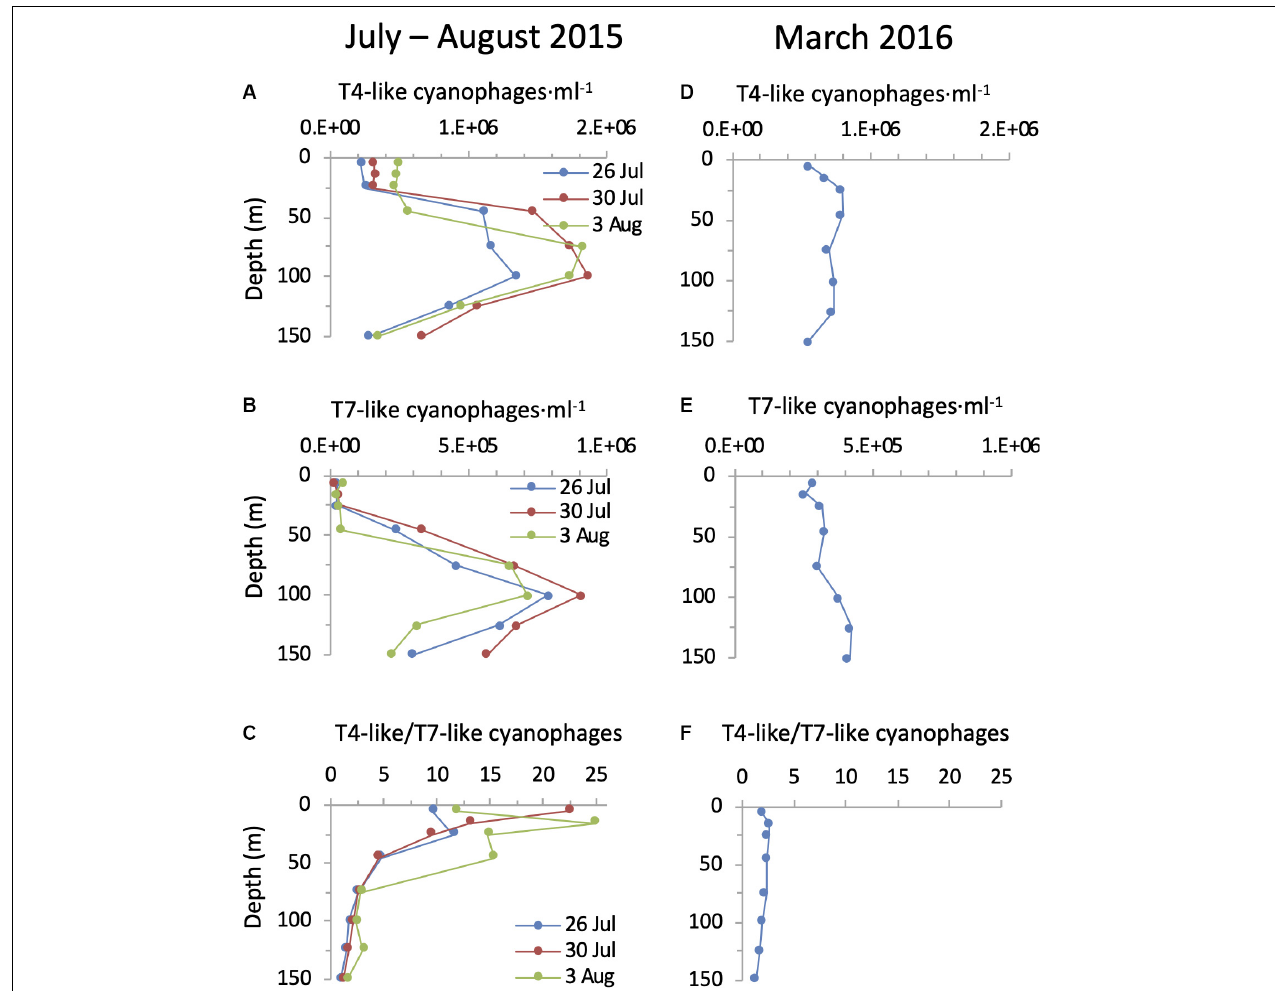
FIGURE 6 | Depth distribution of cyanophages in the NPSG. Abundances of T4-like cyanophages (A,D) , T7-like cyanophages (B,E) and the ratio of T4-like to T7-like cyanophages (C,F) during the summer cruise in July–August 2015 (left panels) and in the spring cruise in March 2016 (right panels). T4-like and T7-like cyanophages were quantified using the polony method. Cyanophage abundances with 95% confidence intervals are presented for each profile in Supplementary Figure 1